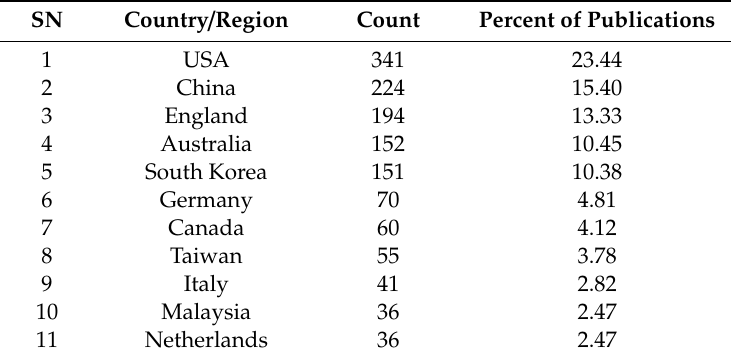
Table 3. Top 10 productive BIM articles countries / regions.